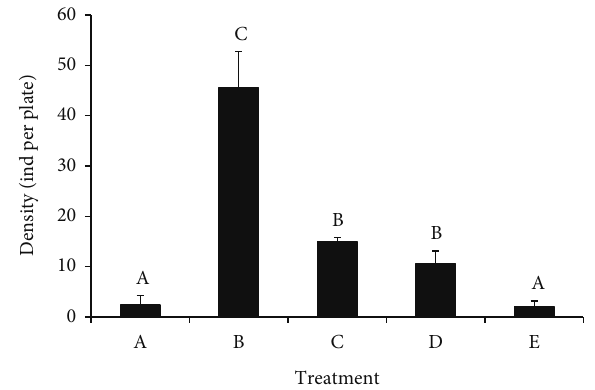
Figure 5: Density of Holothuria leucospilota juveniles on settlement plates in di ff erent diet treatments. Data are presented as means ± SD ( n = 3 ). Di ff erent letters above bars indicate signi fi cant di ff erences among